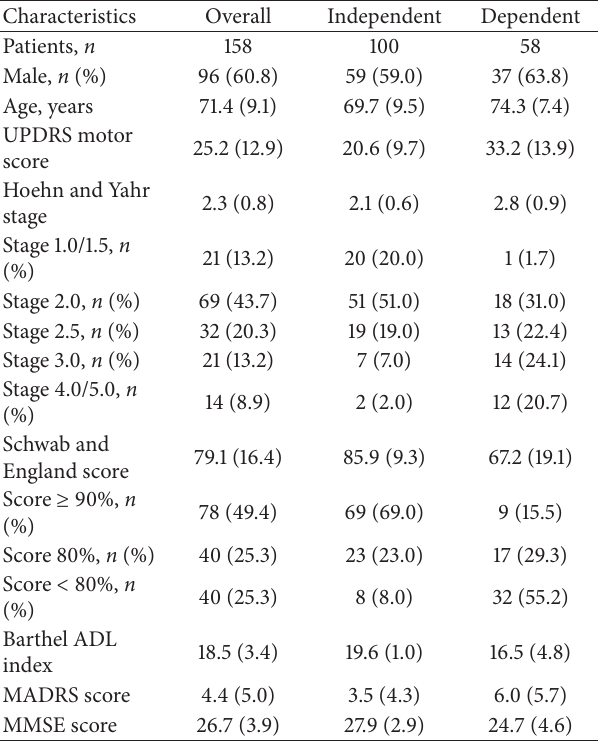
Table 1: Characteristics of the 158 Parkinson’s disease patients at the 5-year